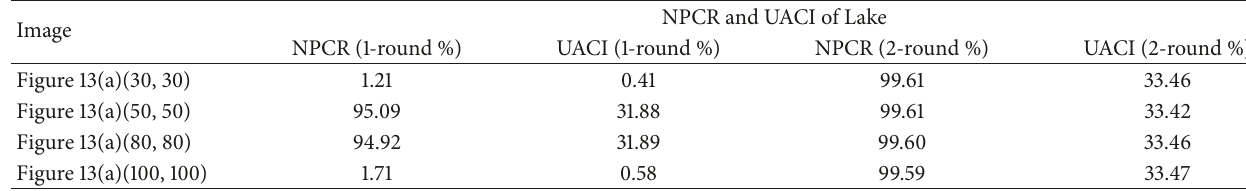
NPCR and UACI of